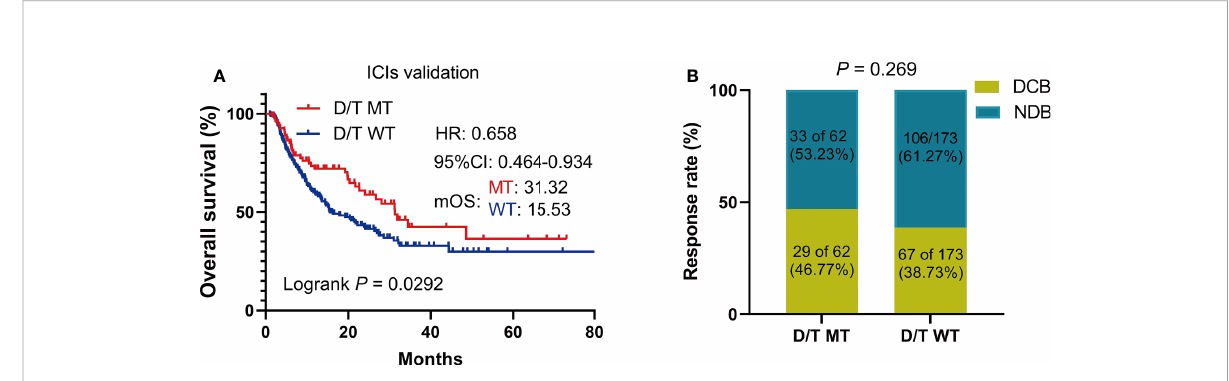
FIGURE 6 The survival signi fi cance of PTPRD/PTPRT mutation in another ICIs-treated cohorts (Miao et al. and Huguo et al., n = 277). (A) Association between PTPTD/PTRT mutation and OS in pan-cancer treated with ICIs. (B) Response to ICIs in PTPRD/PTPRT mutated versus WT patients. DCB: durable clinical bene fi t; NDB: no clinical bene fi